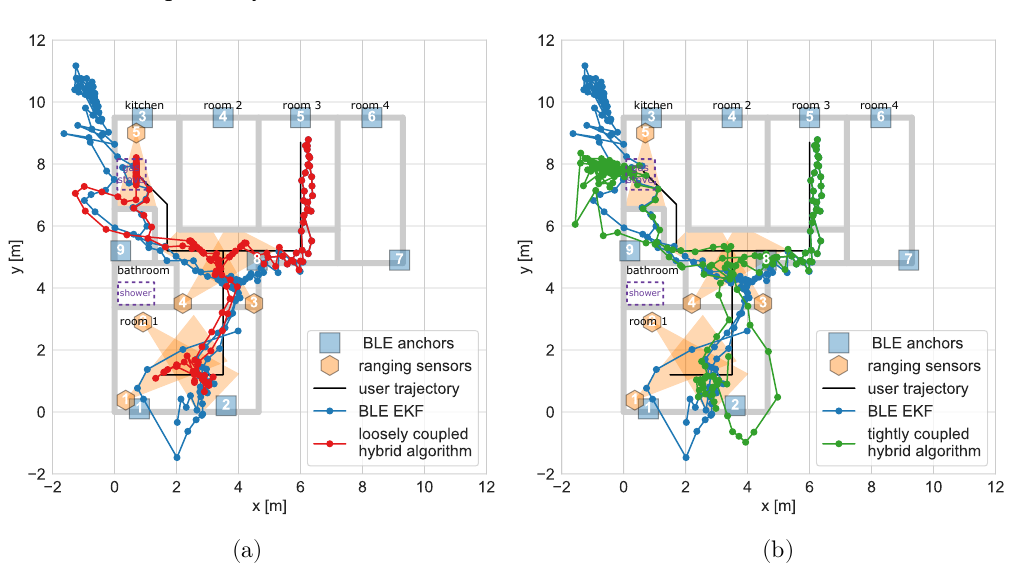
Figure 4. Scenario 1 results obtained with: ( a ) loosely coupled hybrid algorithm, ( b ) tightly coupled hybrid algorithm with BLE-based localization results as